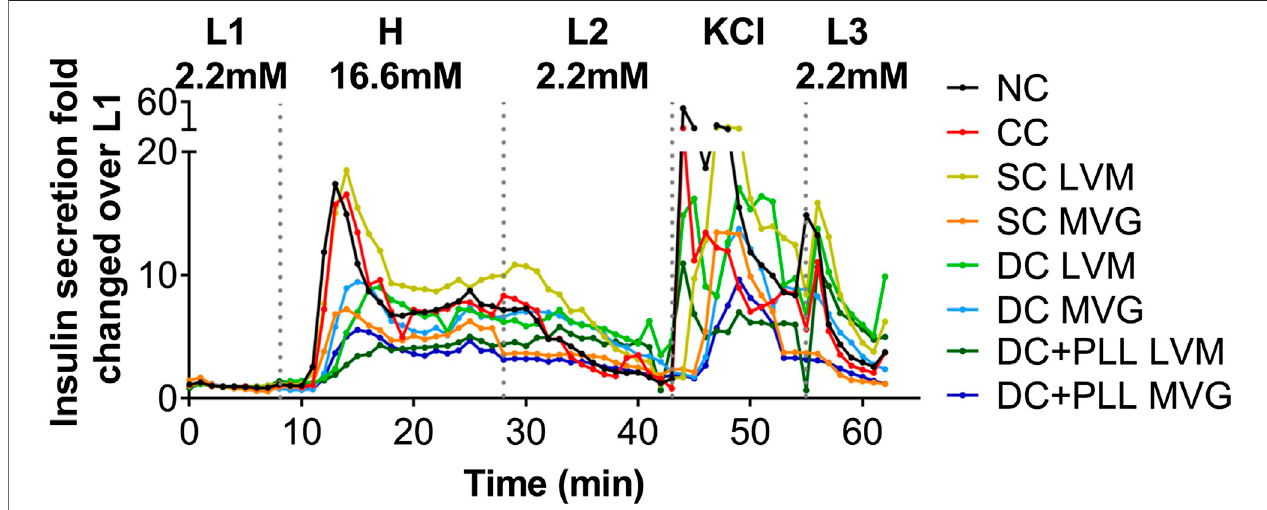
FIGURE3| InvitrodynamicGSISofmicroencapsulatedcomparedwithnon-coatedhumanislets.(A)DynamicGSIS(perifusionassay;100 μ L/min)ofhumanislets (HIs)thatarenon-coated(NC,black)orencapsulatedusingconformalcoating(CC,red),singlealginateMVGcapsules(SCMVG,orange),doubleMVGcapsuleswithout (DC MVG, light blue)or with PLL (DC + PLL MVG, dark blue), single alginate LVM capsules(SC LVM, yellow), doubleLVM capsuleswithout (DC LVM, lightgreen) or with PLL (DC + PLL LVM, dark green). Islets (handpicked 100 IEQs) were perfused for a total of 63 min with 2.2 mM low (L1) glucose (0 – 7 min), 16.6 mM high